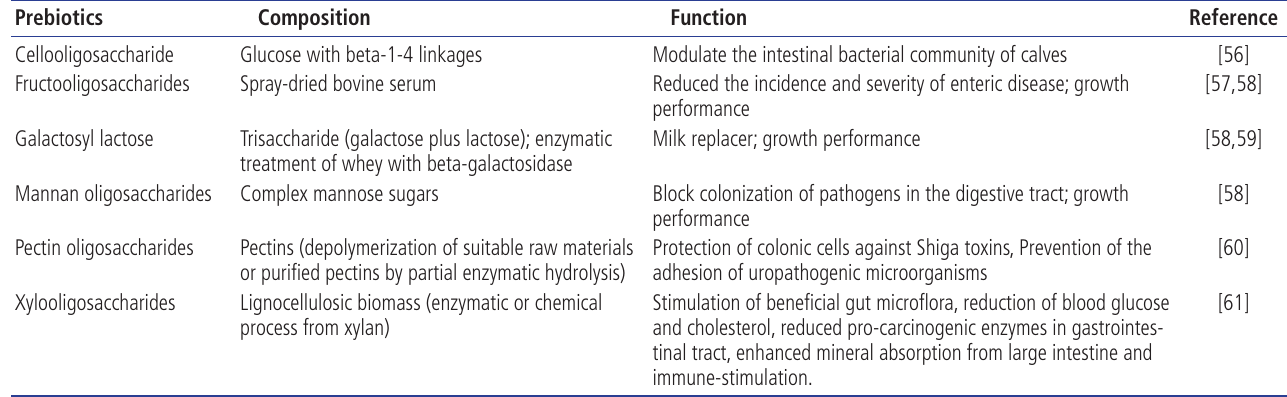
Table 2. List of prebiotics and their functions